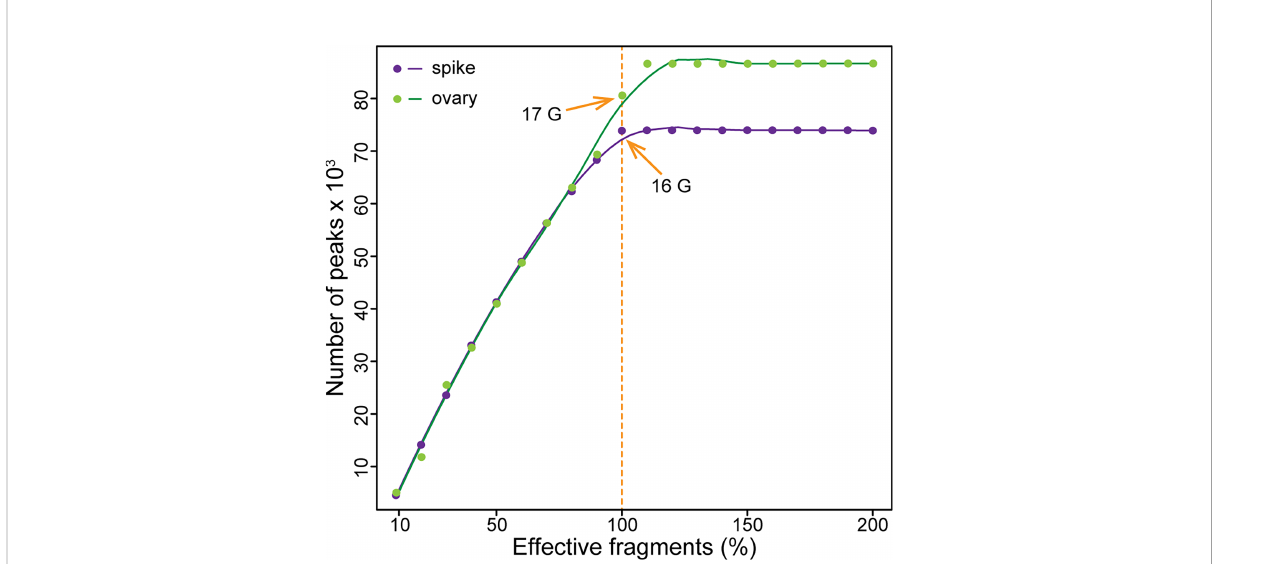
FIGURE 3 Sequencing saturation for ATAC-seq in wheat. The orange arrows indicate the saturated sequencing depth for ATAC-seq in wheat. The purple dots represent the peak numbers of double-ridge stage young spike at different sequencing depths, and the green dots represent that of ovary at 2 days after